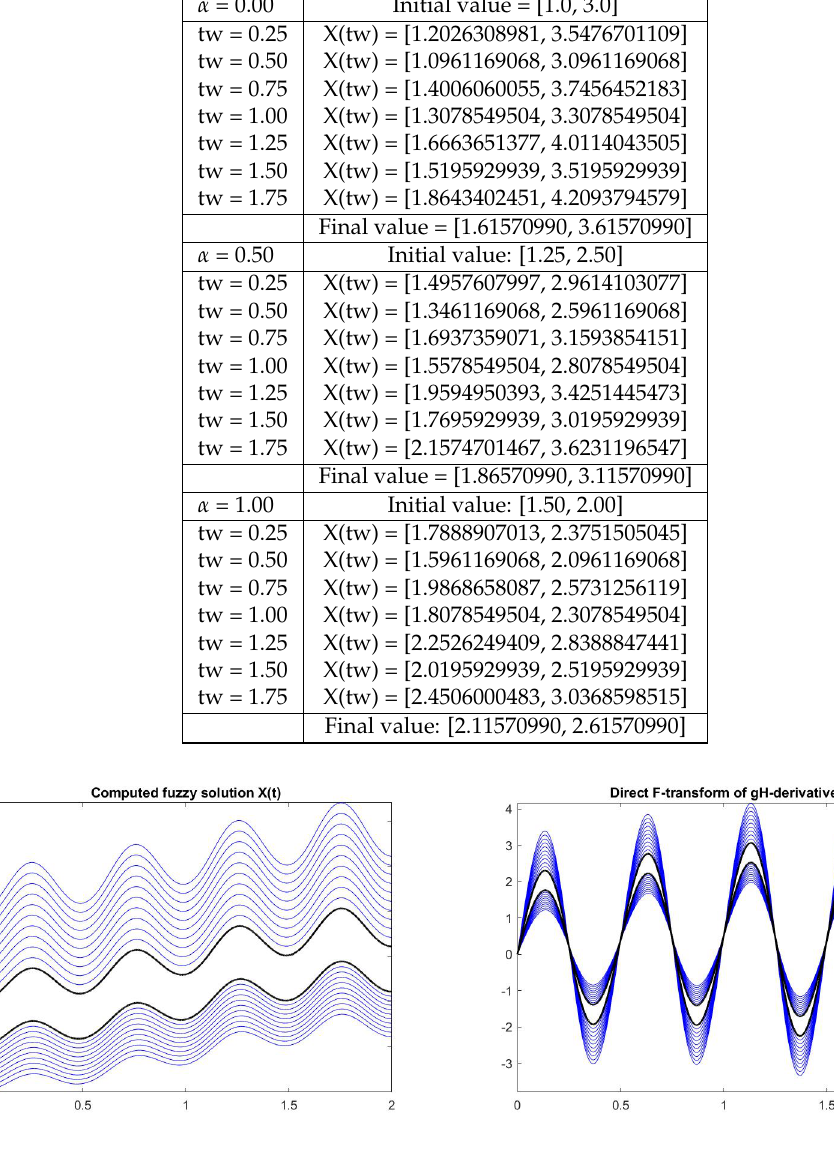
Figure 9. Problem IDE1, Meth = 1: Level-wise LgH-differentiable solution ( left ) and its LgH-derivative ( right ). There are seven switching points which are in the same position for all level α and correspond to the values of t where the gH-derivative is